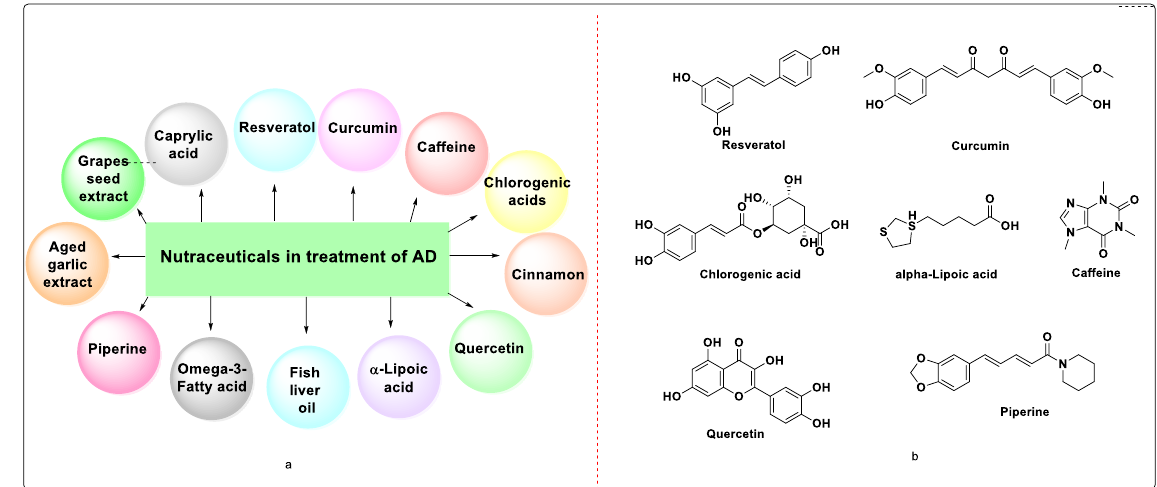
Figure 6. ( a ) Nutraceuticals used in the treatment of AD; ( b ) Structures of Nutraceuticals.